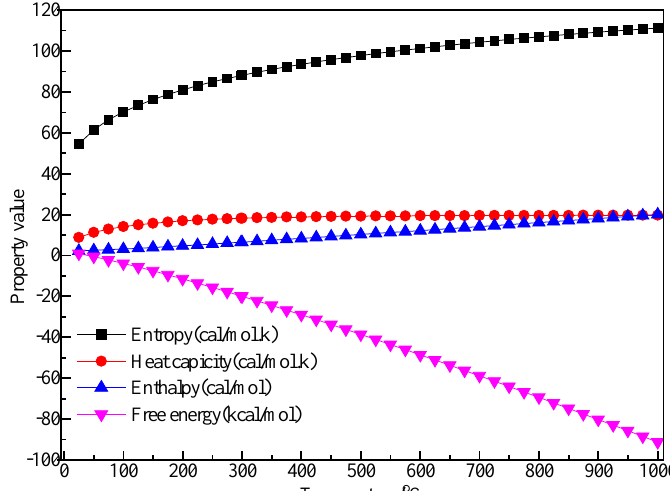
Figure 10. Molecular model of AlBr 3 molecule. ( a ) Initial model; ( b ) Optimized model. The unit of the angle in the image is (°), and the unit of the bond length is angstrom (Å).